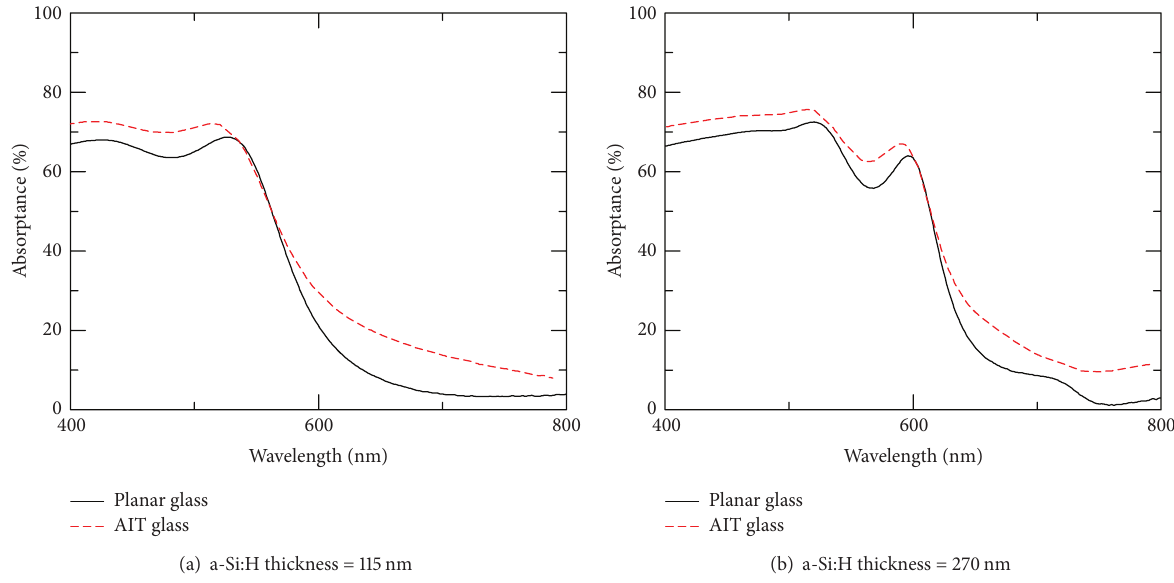
Figure 3: Measured total optical absorptance of glass/a-Si:H (intrinsic) samples on planar glass and AIT glass. The intrinsic a-Si:H layer has a thickness of (a) 115nm and (b) 270 nm. The structure of the textured sample is shown in Figure 2(a).